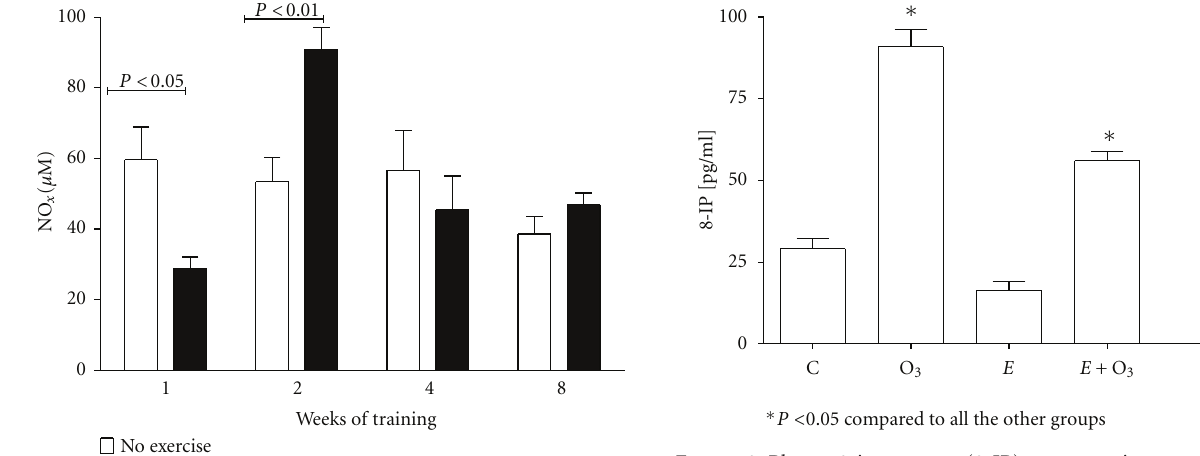
Figure 3: Plasma 8-isoprostane (8-IP) concentrations at week two. Ozone (O 3 , 0.5 ppm 4 hours/day) exposure significantly increased 8-IP levels. Even though exercise (90min per day) did not change 8-IP, it partially but significantly blocked the O 3 e ff ect. Data were analyzed using the one-way ANOVA test and Tukey’s multiple comparison test post hoc . Data are shown as the mean ± standard error of mean ( n = 6 per group).